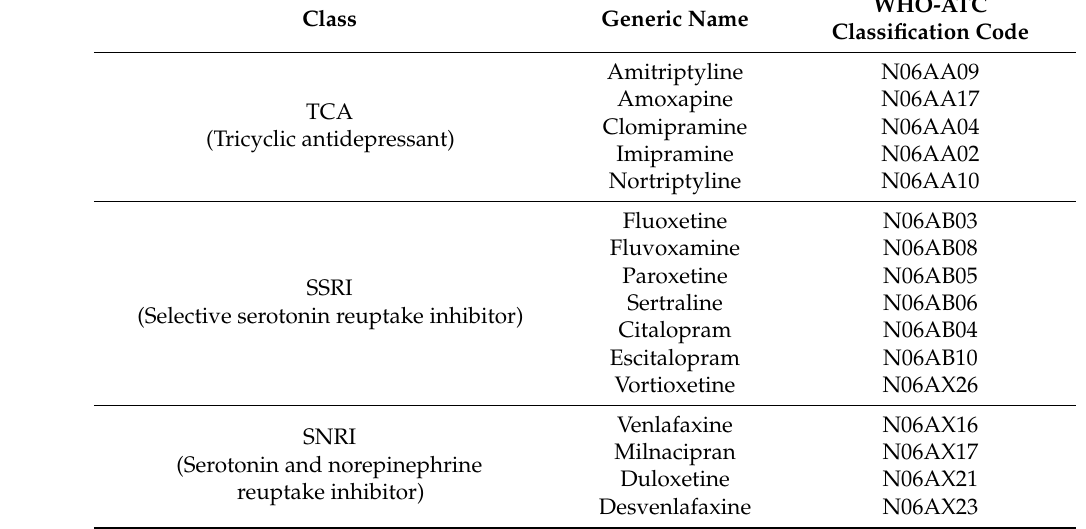
Table A2. Demographic characteristics of depression by payment